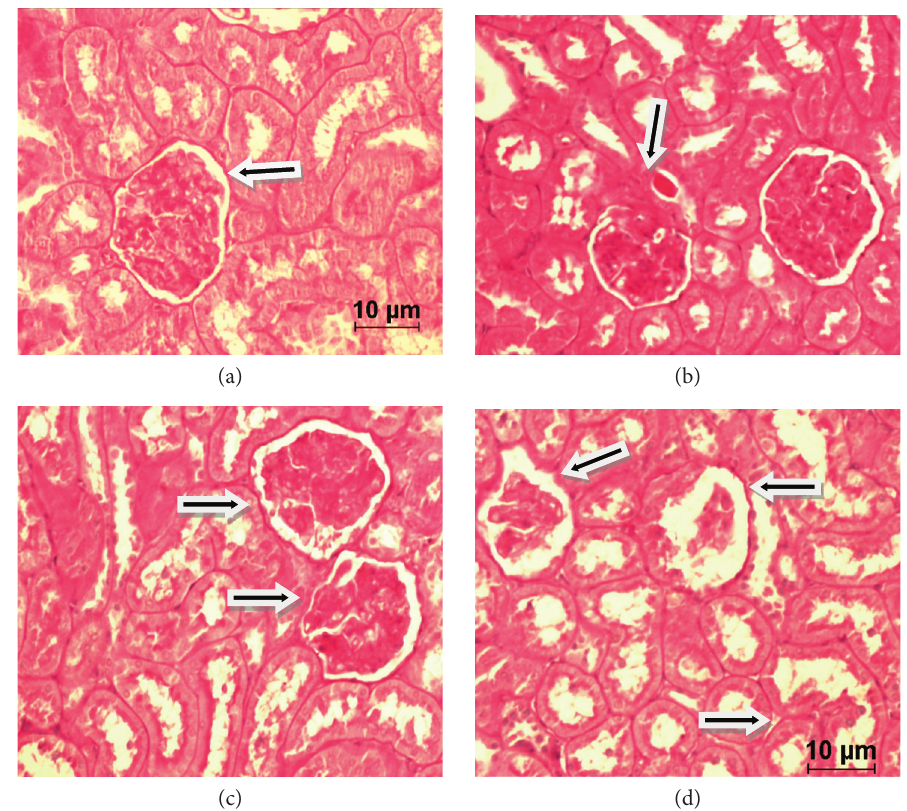
Figure 5: (a, b, c, d) (PAS 40x magni fi cation. Scale bar = 10 μ m.) (a) Control group: normal glomeruli (arrow). (b) Fructose group: glomeruli slightly decreased in size (arrow). (c) Oxonic acid group: glomerulosclerosis (arrows). (d) Fructose and oxonic acid group: total glomerulosclerosis (arrows). These alterations were observed in both groups (normogonadic and hypogonadic